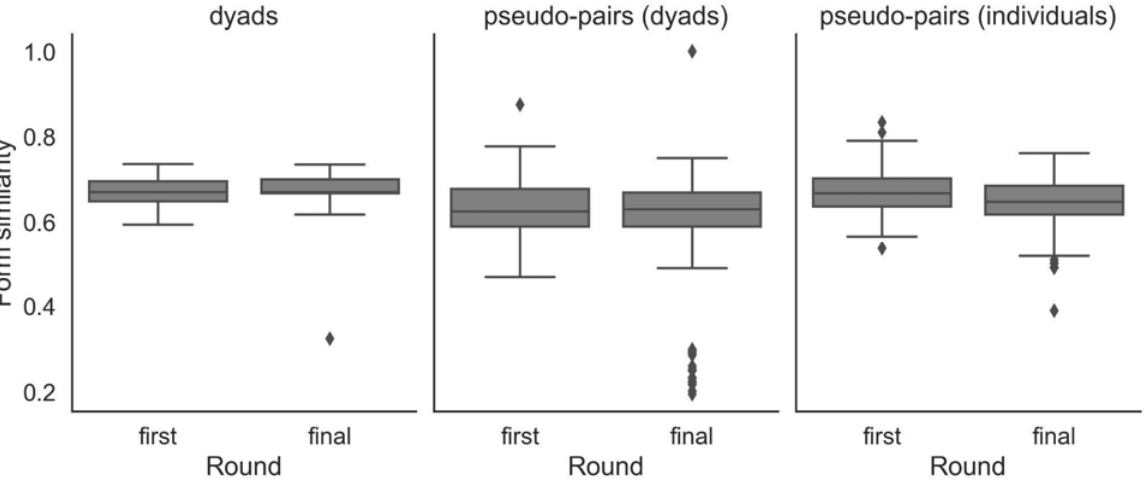
Figure 12. Similarity in form parameters across rounds for real ‐ paired dyads (left panel) and pseudo ‐ dyads, made up of participants in the dyadic condition paired with participants with whom they did not interact (middle panel) and participants in the individual condition (right panel), paired with other individuals with whom they did not interact.